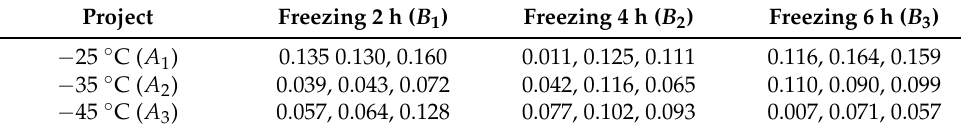
Table 10. Adhesion strength of AL-Ice-SR test piece.